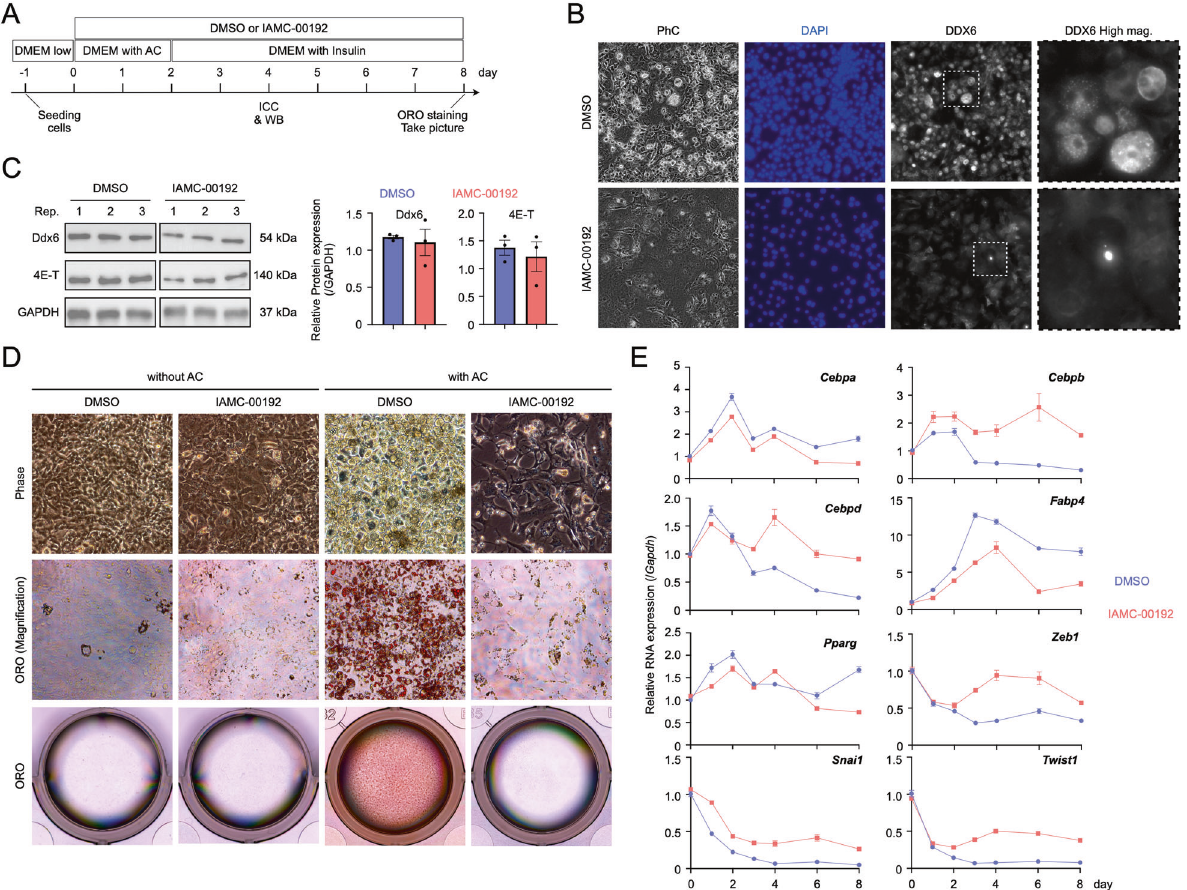
Fig. 4 Inhibition of processing body formation during induction of adipogenic differentiation. A Experimental design for induction of adipogenic differentiation: DMEM low DMEM low glucose with 10% FBS, AC adipogenic-cocktail (AC) containing insulin, IBMX, and dexamethasone. ICC Immunocytochemistry. WB Western Blotting. ORO Oil Red O. B Immunocytochemical staining using DDX6 antibody. 3T3- L1 cells were fi xed and stained on day 4 of adipogenic differentiation. C WB analysis of 3T3-L1 cells on day 4 of stimulation for adipogenic differentiation. The graph shows the expression ratio of each protein corrected by Gapdh protein expression level. Rep replication. D Phase- contrast images (top row) and ORO staining results (middle and bottom rows) of 3T3-L1 cells on day 8 of stimulation for adipogenic differentiation. The middle row is a magni fi ed image, and the lower row is the entire image of well (12-well plate). E Gene expression analysis of 3T3-L1 cells stimulated by the adipogenic differentiation over time by qPCR. Design of the analysis of RNA expression in the cytoplasm and